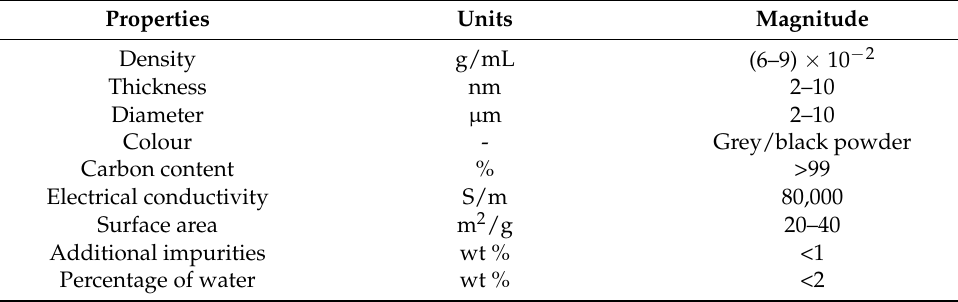
Table 4. Relevant properties of graphene